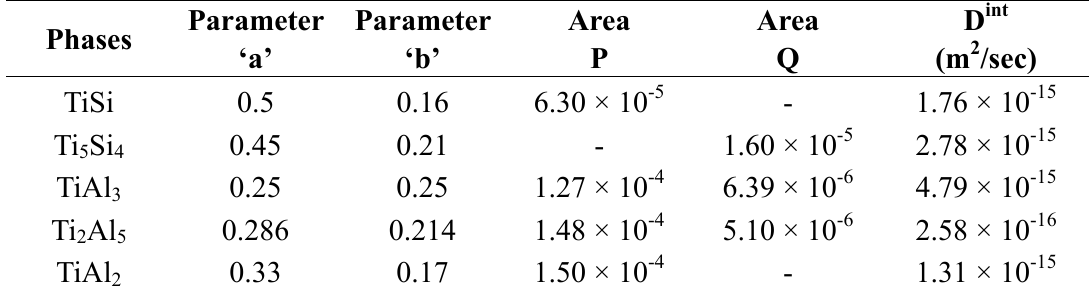
Table 3. The estimated integrated diffusion coefficients and the related